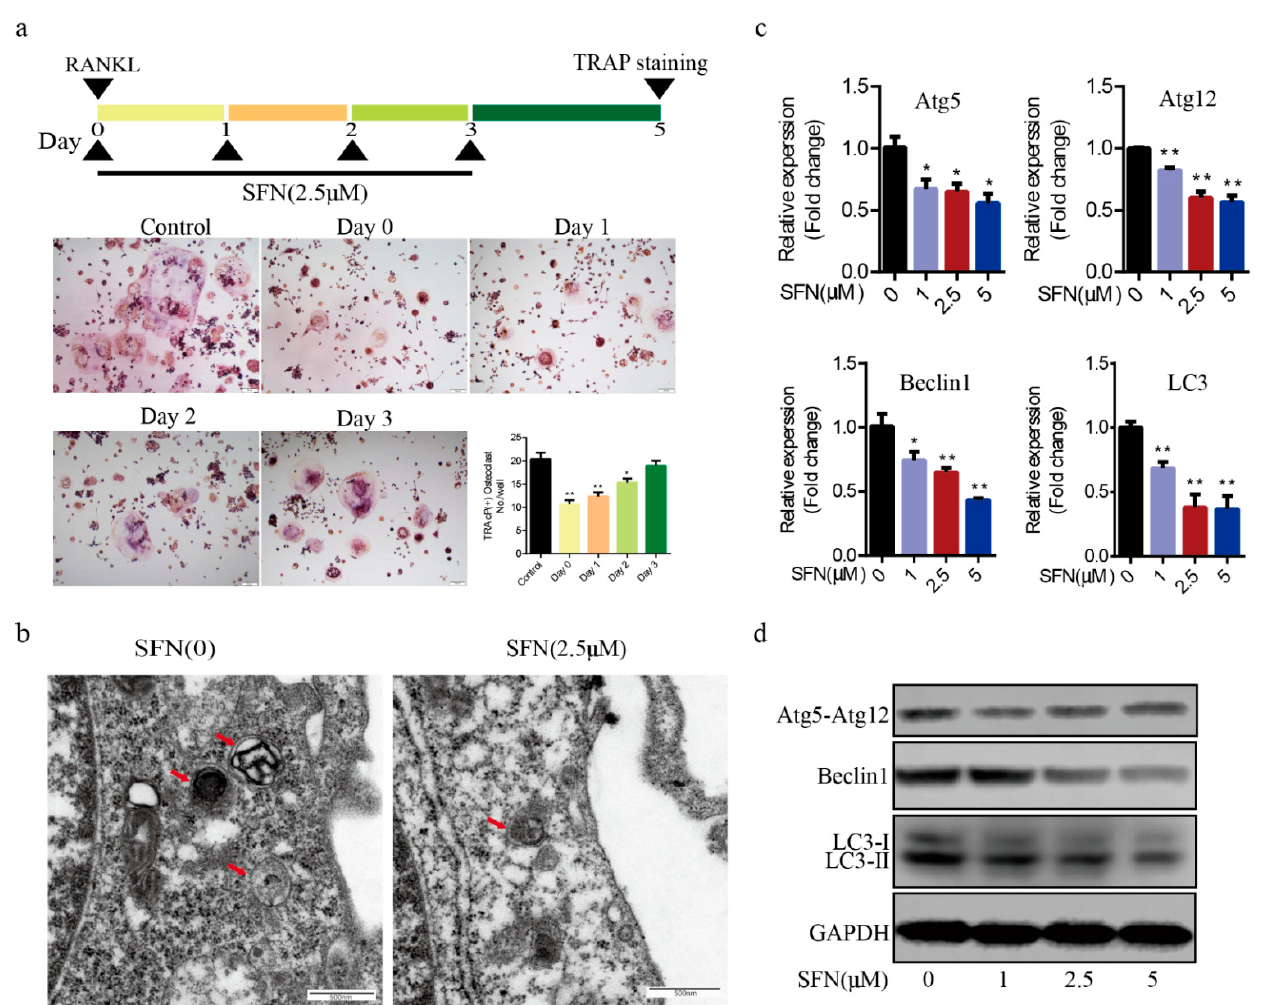
Figure 3. SFN treatment blocked the autophagic pathway in pre-osteoclasts. RAW264.7 cells were cultured with 50 ng/mL of RANKL for 5 days plus 2.5 μ M SFN at the indicated time points. ( a ) Representative images showing osteoclastogenesis in each group and corresponding statistics. To explore the effect of SFN on autophagy in pre-osteoclasts, we stimulated RAW 264.7 cells with SFN for 2 h and then treated them with 50 ng/mL of RANKL for 24 h. ( b ) Representative images of autophagosomes (red arrow) as observed by TEM. ( c , d ) Representative qRT-PCR and WB results showing the effects of SFN on autophagic molecules (Atg5, Atg12, Beclin1, and LC3) expression. Values are mean ± SEM of three independent experiments; * p < 0.05, ** p < 0.01.